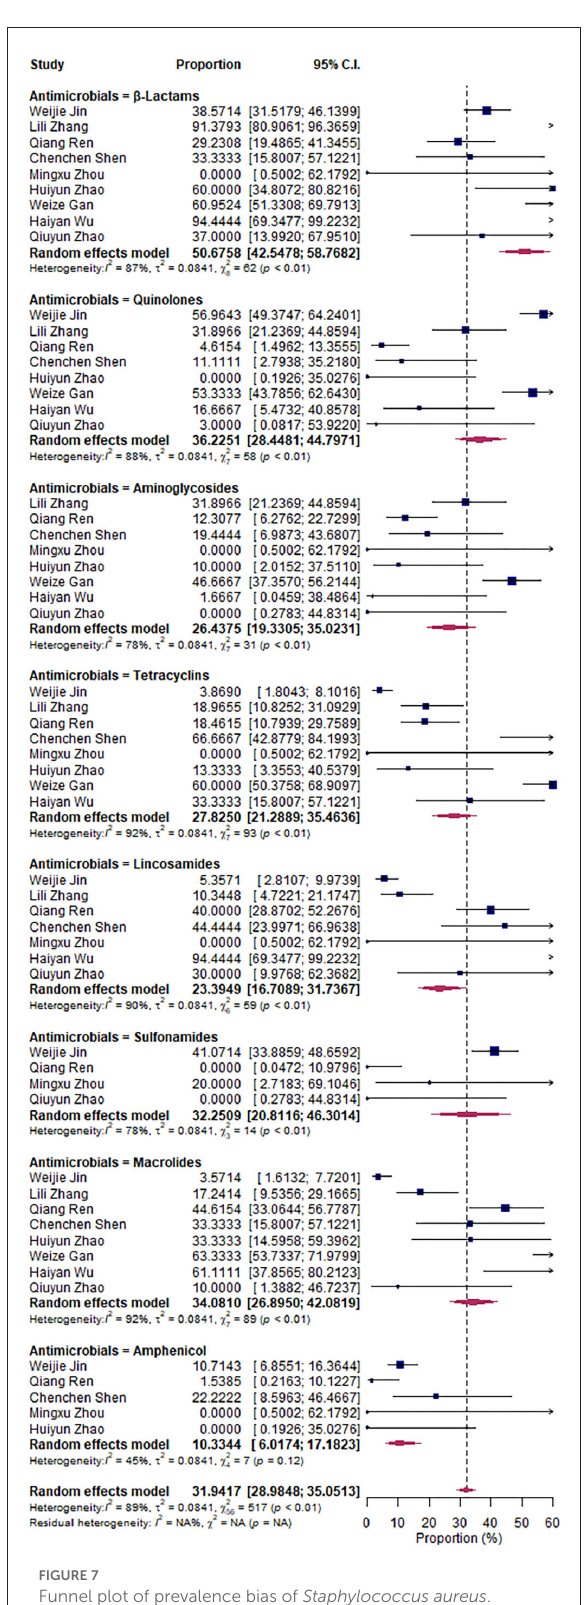
FIGURE7 Funnel plot of prevalence bias of Staphylococcus aureus